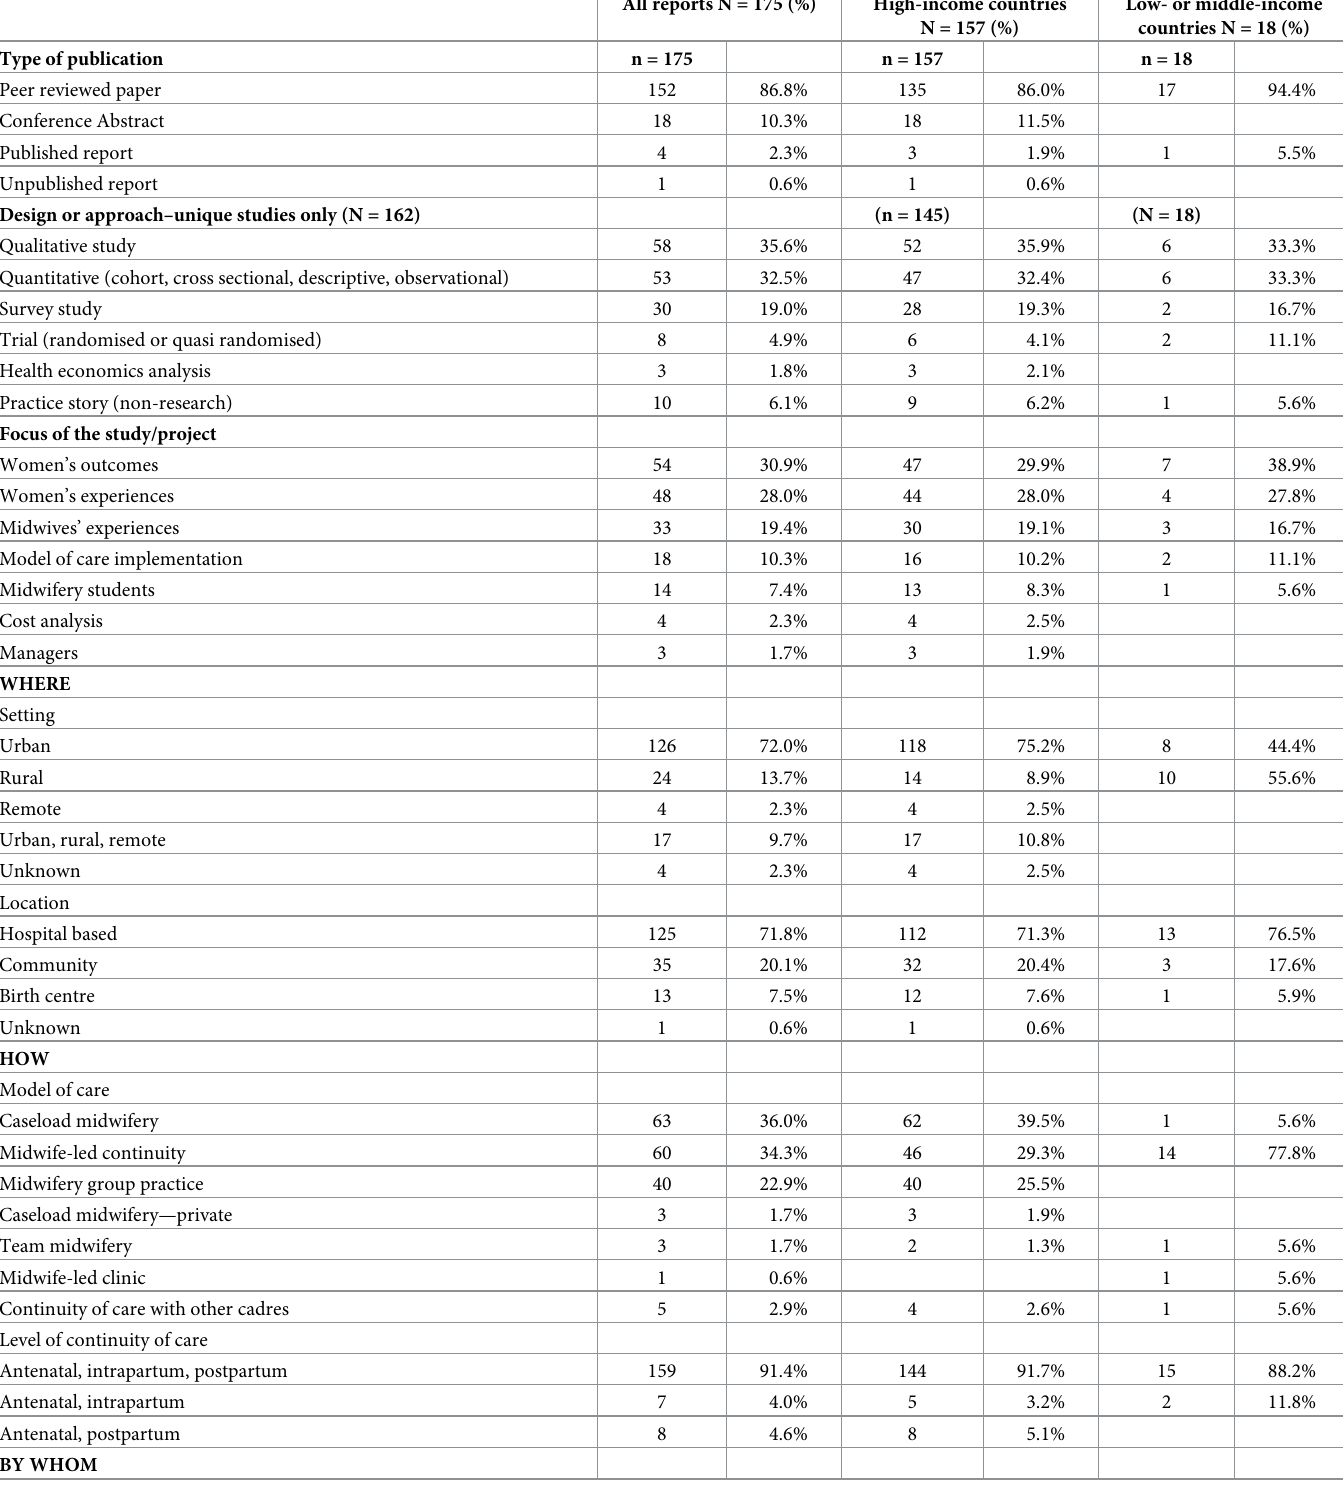
Table 2. Midwifery continuity of care: Where, how, by whom and for whom by income